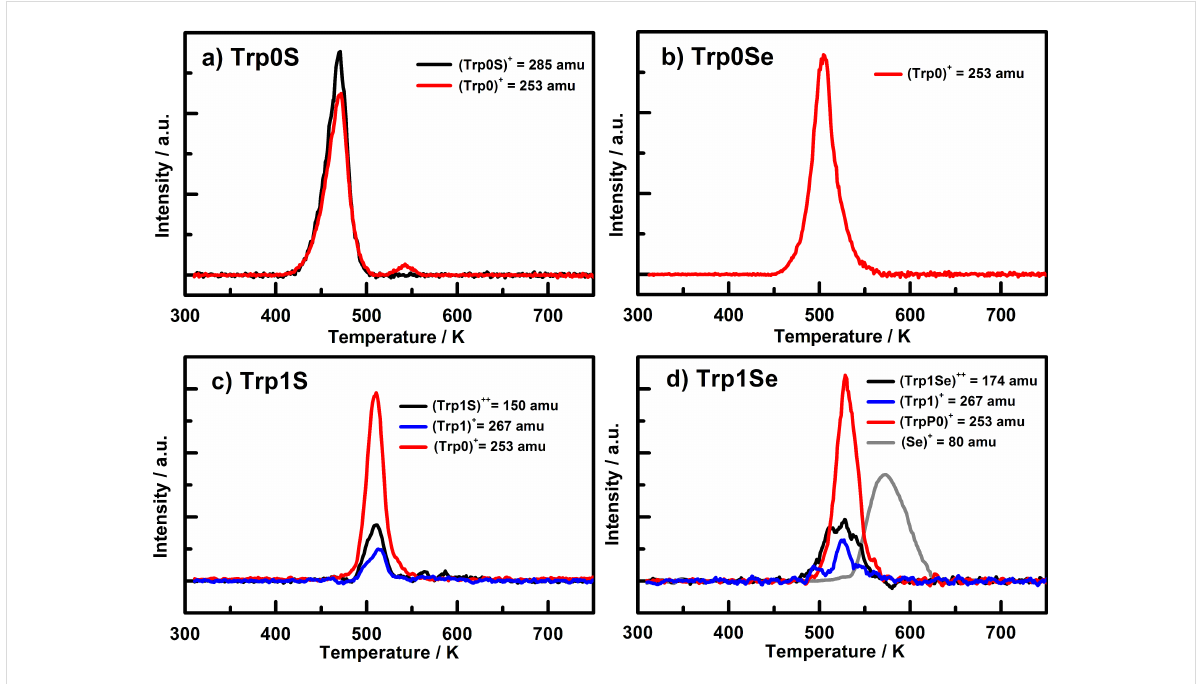
Figure 8: Thermal desorption spectra of a) Trp0S-, b) Trp0Se-, c) Trp1S- and d) Trp1Se-SAMs on Au(111). See text for